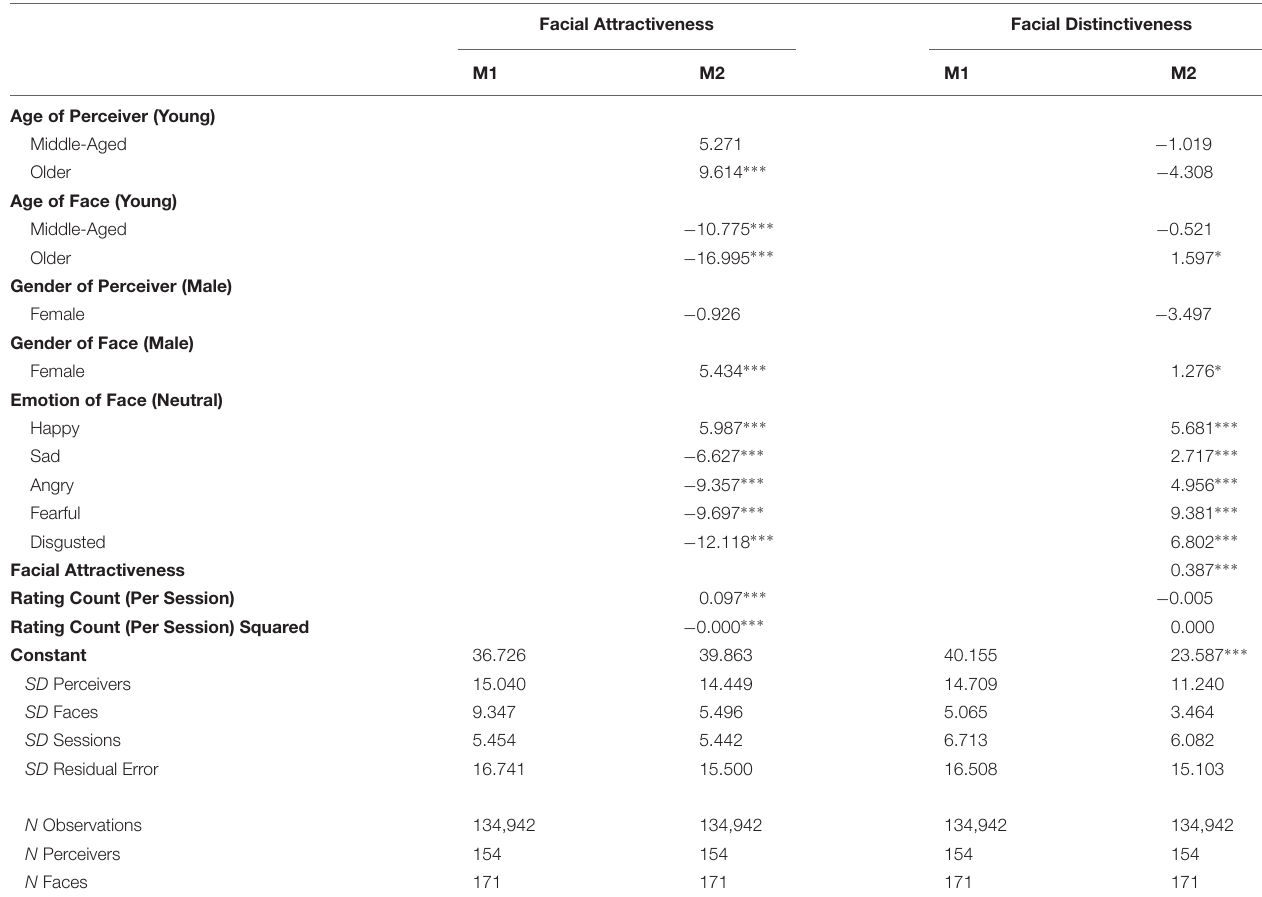
TABLE 2 | Cross-classified random effects linear regression models.